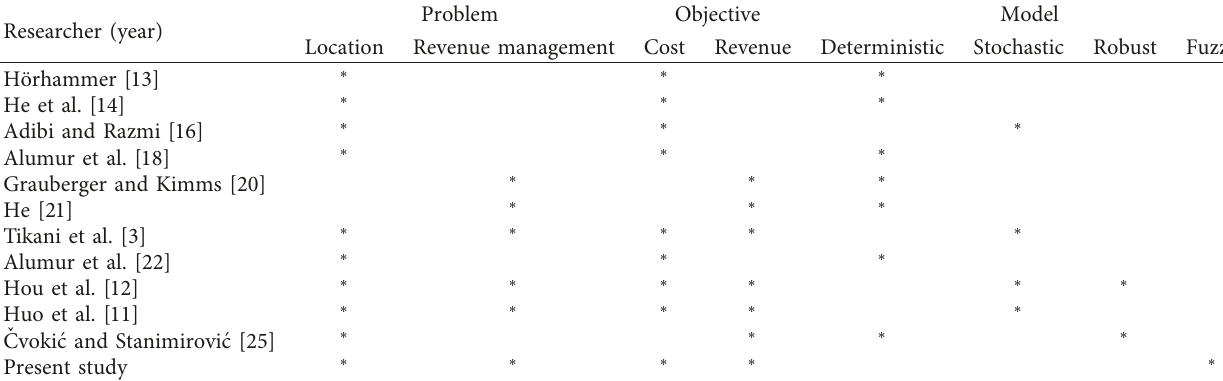
Table 1: Summary of previous